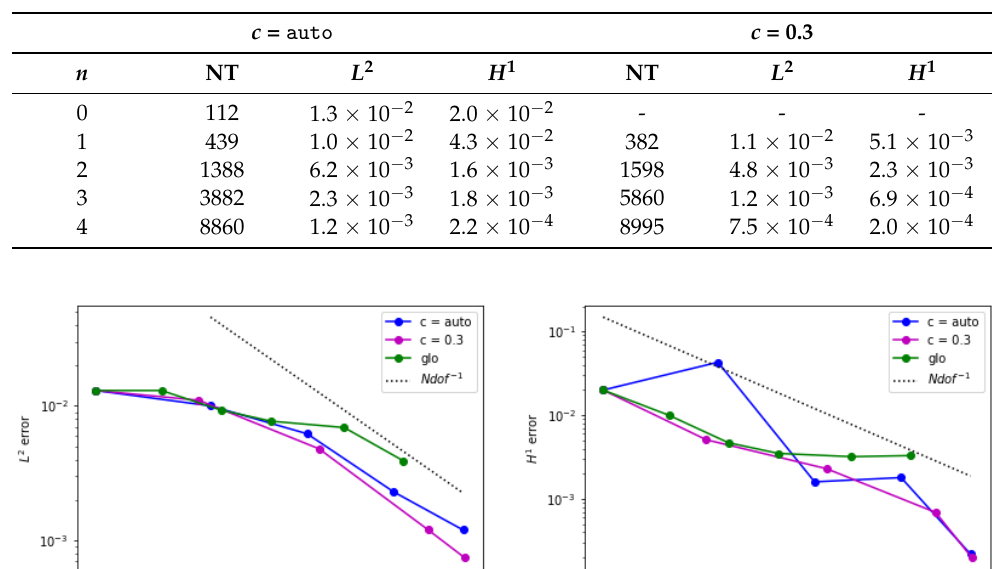
Table 1. L 2 norm and H 1 seminorm of the error for example 1. The residual-based error estimator was employed.